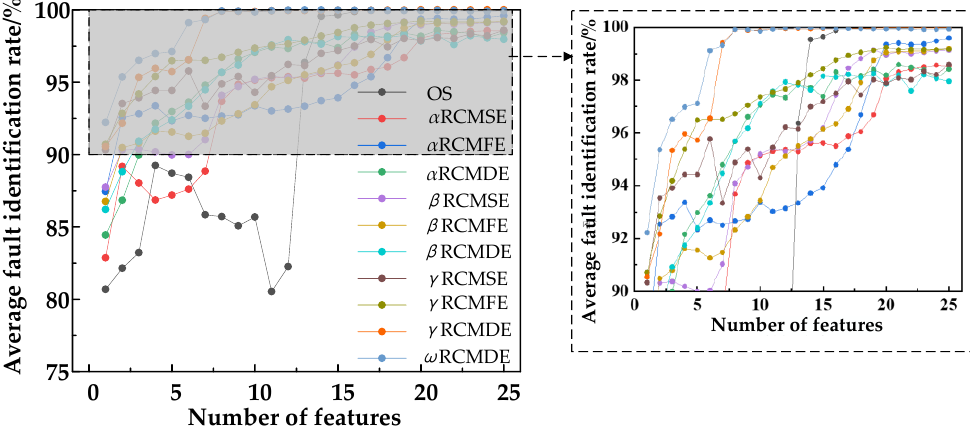
Figure 32. ω RCMWE entropy values of 25 scale factors under different damage degrees.